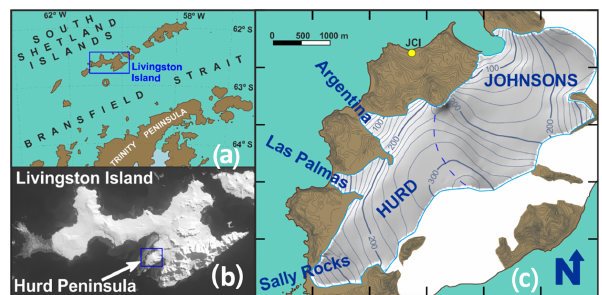
Figure 1. (a) Location of Livingston Island in the South Shetland Archipelago. (b) Location of Hurd Peninsula on Livingston Island (orthophoto generated from SPOT 1991 image by Universitat de Barcelona and Institut Cartogràfic de Catalunya, 1992). (c) Loca- tion and surface elevation map of Hurd and Johnsons glaciers, Hurd Peninsula, Livingston Island. The dashed blue line indicates the ice divide separating Hurd and Johnsons glaciers. Elevations and out- line are based on a survey during summer 1998/99 and 2000/01. The yellow dot shows the position of Juan Carlos I Station